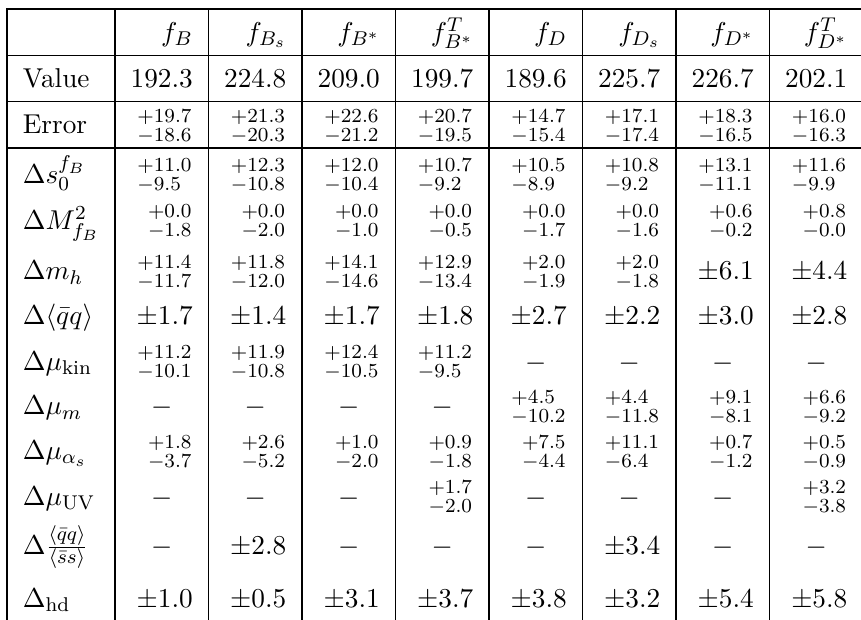
Table 9 . Breakdown of the main contributions to the uncertainty for a representative selection of decay constants in units of MeV in the kinetic scheme. The uncertainty ∆ hd covers higher dimensional condensates omitted from the OPE which are estimated as the values of the d = 4 , 5 condensates. This is conservative as the four quark condensates are known to be a sub per mille effect. The total uncertainty also includes contributions not shown in the table, such as ∆ m 2 has a negligible